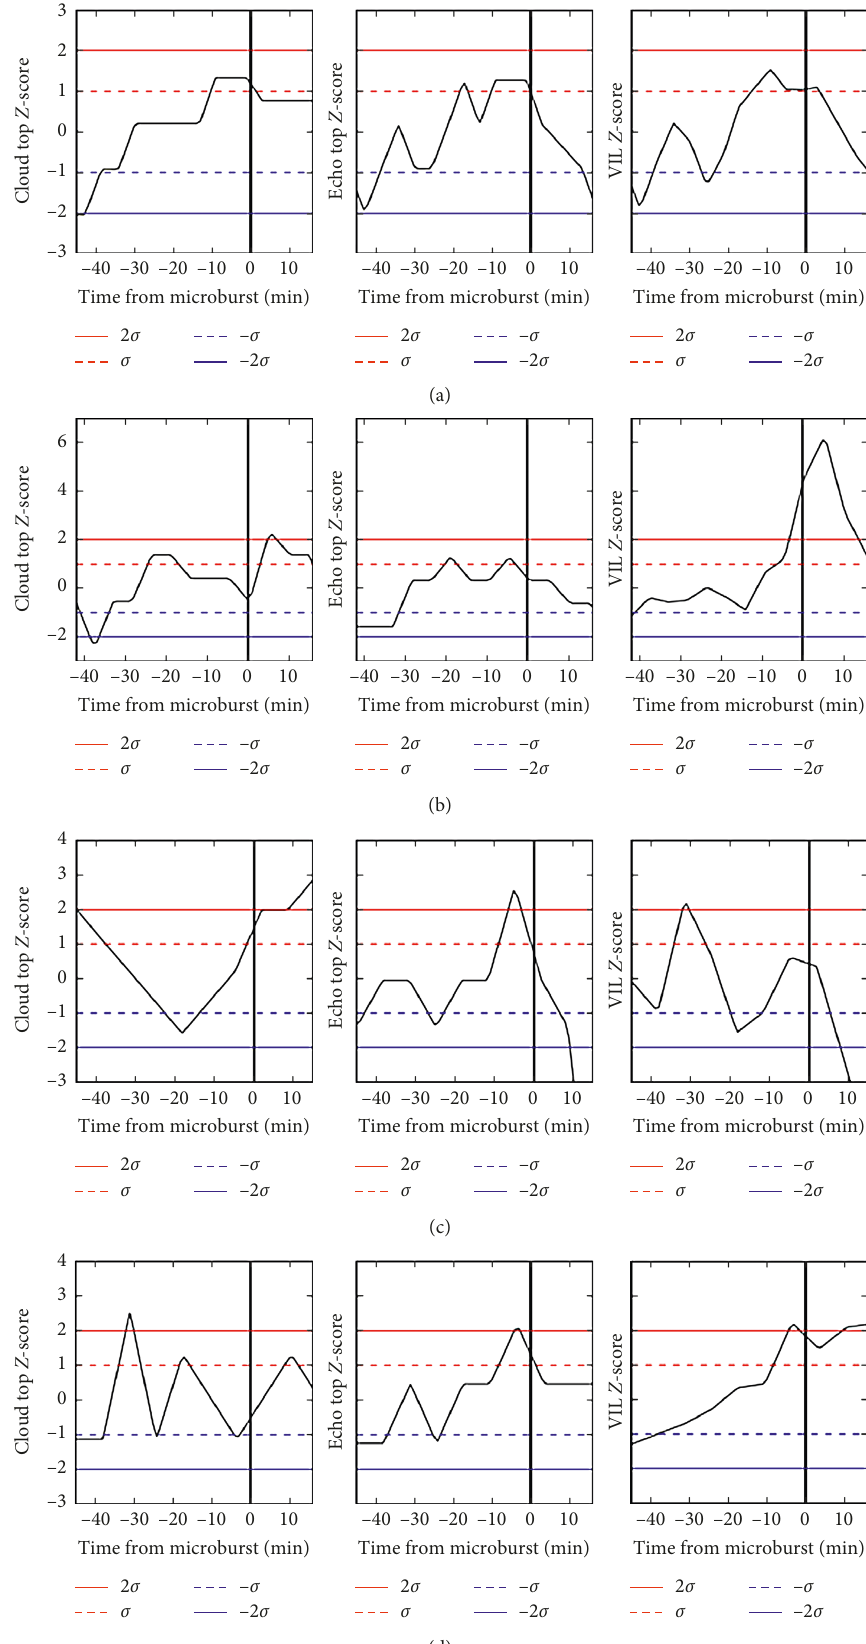
Figure 15: As in Figure 14, but for the last four severe wind cases. (a) 20150623 null. (b) 20150630 null. (c) 20150803 null. (d) 20160701